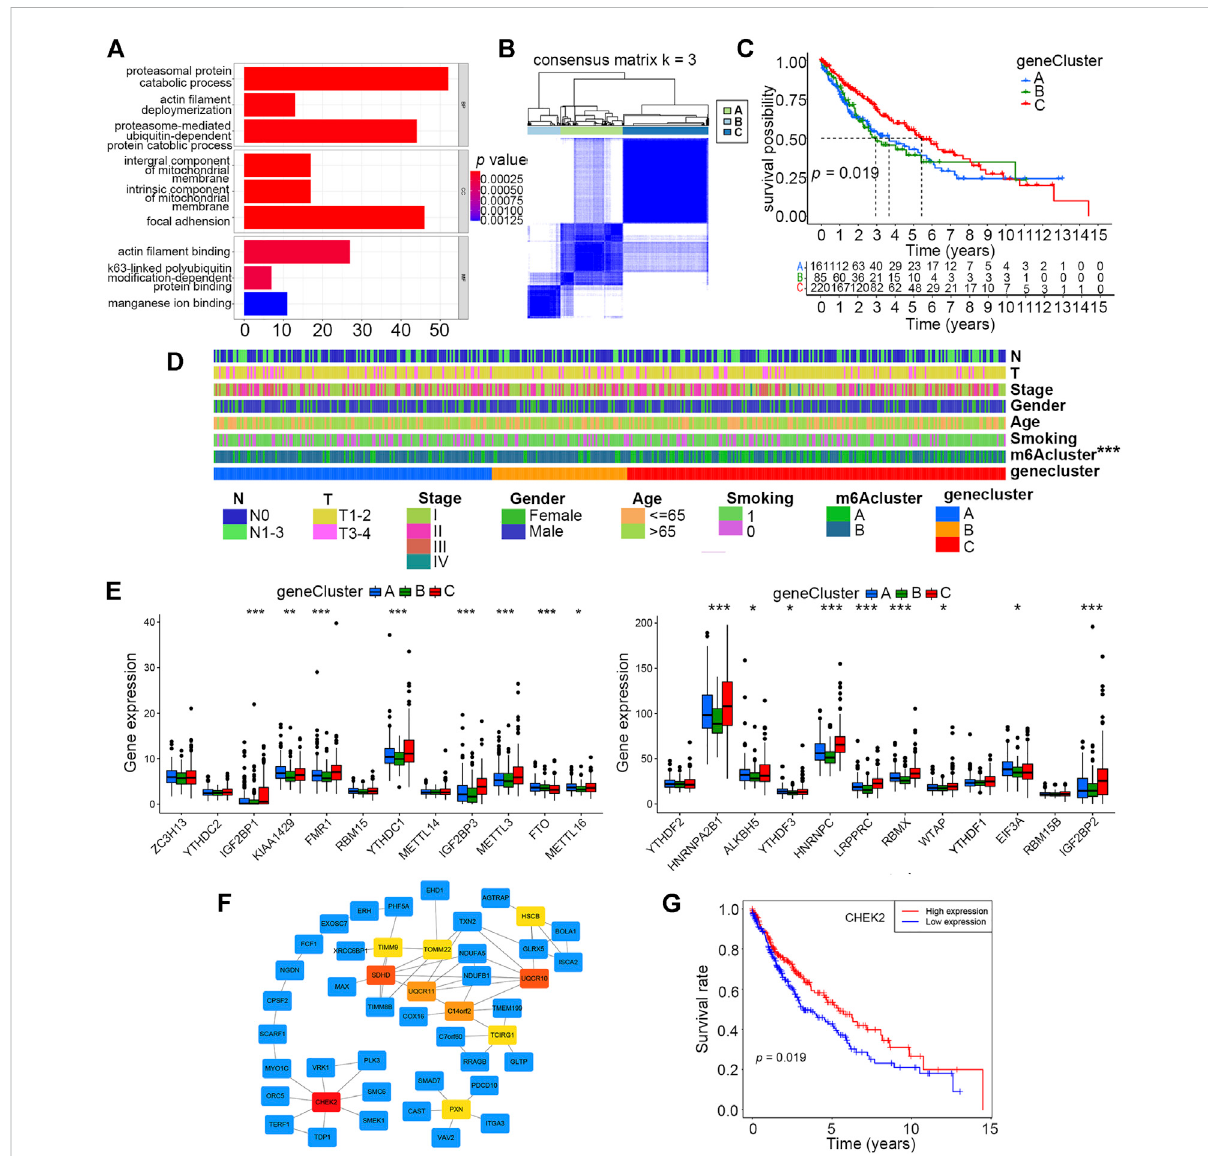
FIGURE 3 Identi fi cationofthreedistinctgeneclustersbasedonDEGsofm6AclustersAand B . (A) Enrichmentanalysisof1814DEGsofm6AclustersAand B by GO. (B) Identi fi cation of three distinct gene clusters based on 230 prognostic DEGs of m6A clusters A and B via unsupervised consensus clustering analysis. (C) Overall survival differences among m6A clusters A, B, and C by Kaplan – Meier survival analysis. Log-rank p = 0.019. (D) Differences in clinical characteristics and m6A clusters among gene clusters A, B, and C . (E) Differences in expression levels of 24 m6A regulators among gene clusters A,B, and C(* p < 0.05, ** p < 0.01, and *** p < 0.001). (F) Hub gene identi fi cationamongDEGs by Cytoscape software and the Degree algorithm. The top 10 hub genes are marked from pale yellow to deep red, and the darker the color, the more important it is. The other related genes are labeled blue. (G) Overall survival differences between high and low expression levels of CHEK2 in the smoking-associated LUSC cohort by Kaplan – Meier analysis. Log-rank p =